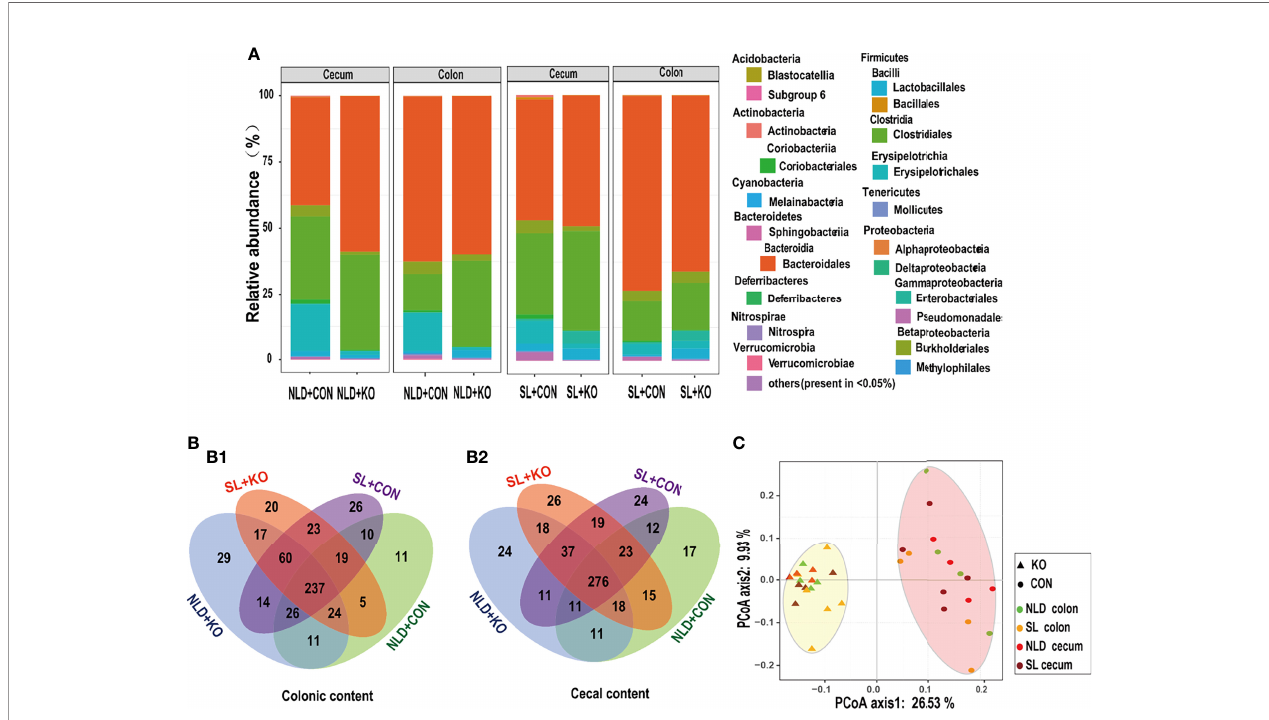
FIGURE 6 | Bacterial diversities and compositions in KO and CON mice under NLD and SL. KO, Per2 gene knockout ( Period2 − / − ) mice; CON, wild-type ( Period2 +/+ ) mice; NLD, normal light – dark cycle treatment of 12 h of light and 12 h of darkness; SL, short-light treatment of 8 h of light and 16 h of darkness. (A) Compositions of colonic and cecal microbiota at the phylum, family, and order levels in KO and CON mice under NLD and SL, the bacterial relative abundance in <0.05% were belonged to others. (B) Venn diagrams based on OTUs in colonic content (B1) and cecal content (B2), the number of unique OTUs were represented by the unoverlapped portion. (C) Principal coordinate analysis plots of unweighted UniFrac distances of microbiota in colonic and cecal contents in KO and CON mice under NLD and SL. n = 6 per group for 16S rRNA